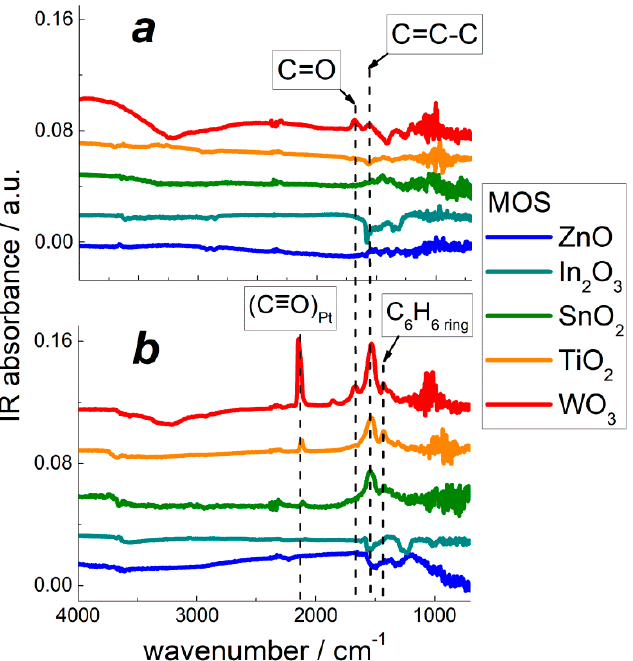
Figure 10. DRIFT spectra of pristine MOS ( a ) and PtO x − modified MOS ( b ) exposed to 10 ppm C 6 H 6 for 1 h at 220 °C.